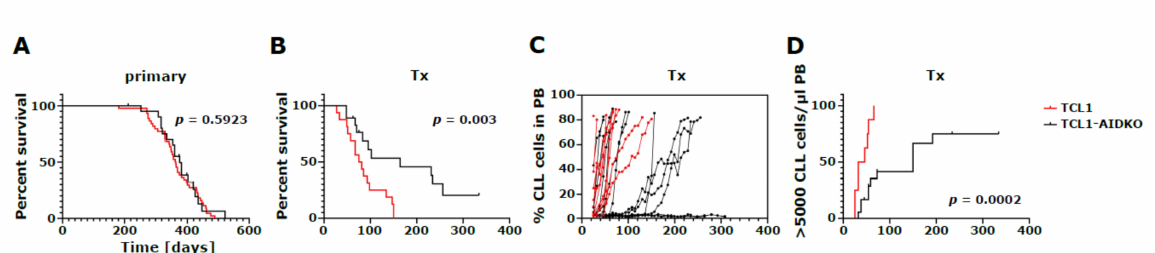
Figure 2. Survival and disease progression of primary and transplanted congenic recipient mice. Overall survival of ( A ) primary tumors with median survival of 363 days in TCL1 mice ( n = 44) and 375 days in TCL1-AIDKO ( n = 25) (log-rank (Mantel–Cox) test: p = 0.5923) and ( B ) transplanted recipient mice with median survival of 78 days in TCL1 Tx ( n = 16) and 164 days in TCL1-AIDKO Tx ( n = 18) (log-rank (Mantel–Cox) test: p = 0.0030). ( C ) CLL disease progression of transplanted mice with TCL1 Tx ( n = 10 of 16 mice shown in B, from which we had FACS data from consecutive blood draws) and TCL1-AIDKO Tx ( n = 16 of 18 mice shown in B, as 2 mice with T cell leukemias were excluded) is depicted as percent CLL cells (defined as CD5 + /CD19 + cells from all lymphocytes as shown in Figure S1) in the peripheral blood (PB). ( D ) Kaplan–Meier analysis of percentage of TCL1 Tx ( n = 8 of 10 mice shown in C, from which we could determine absolute cell numbers per µ l blood) and TCL1-AIDKO Tx ( n = 18) transplanted mice entering the leukemic phase (defined as mice having > 5000 CD5 + /CD19 + cells/ µ l peripheral blood) (log-rank (Mantel-Cox) test: p =